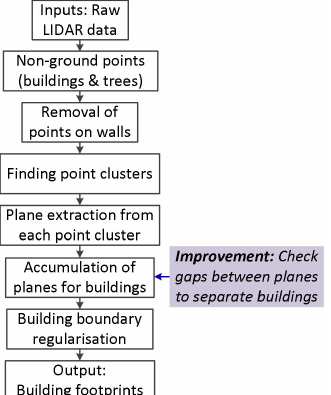
Figure 1: The proposed building detection